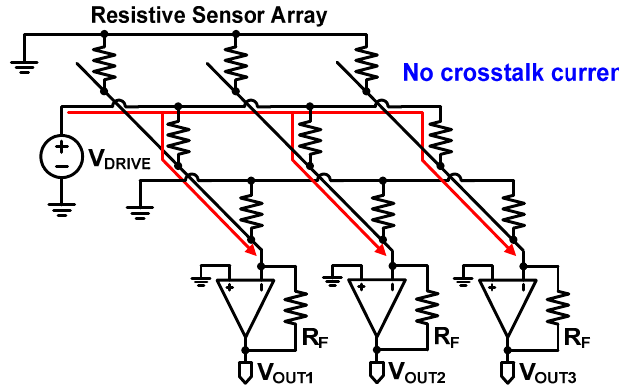
Figure 2. Zero-potential scanning method to eliminate the crosstalk current.